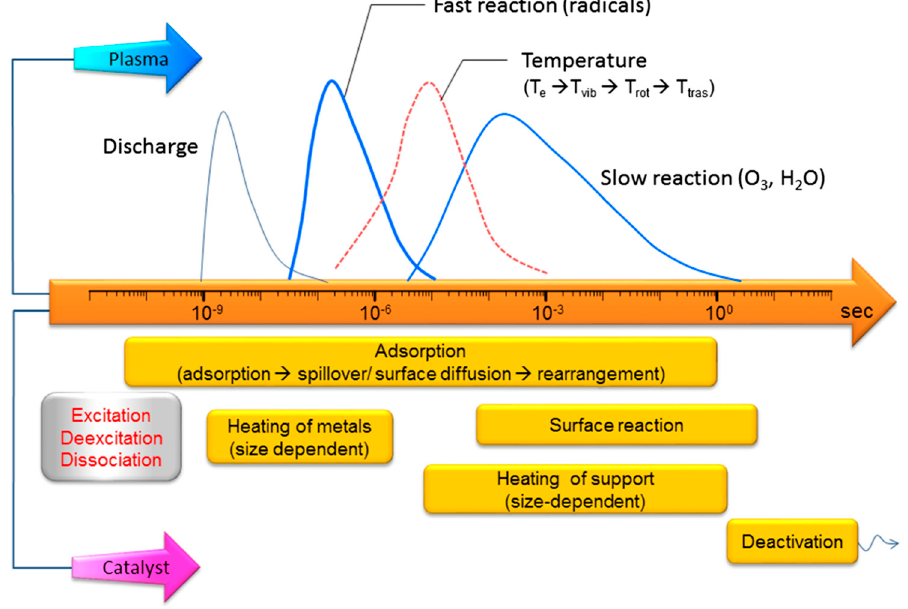
Figure 25. Characteristic time ‐ scales in plasma catalysis. Reproduced with permission from [112]. Copyright, 2015 Springer.